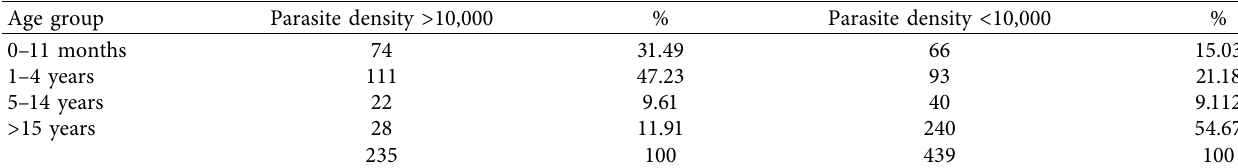
Table 4: Parasite density according to age group.